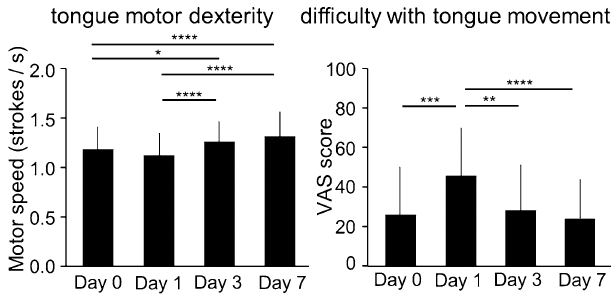
Figure 1. Change in tongue motor dexterity and difficulty of tongue movement (n = 27). Error bars represent standard deviation. Day 0: pre-insertion; Day 1: immediately after insertion; Day 3: 3 days after insertion; Day 7: 7 days after insertion. VAS: visual analogue scale. * P < 0.05, ** P < 0.01, *** P < 0.005, **** P <